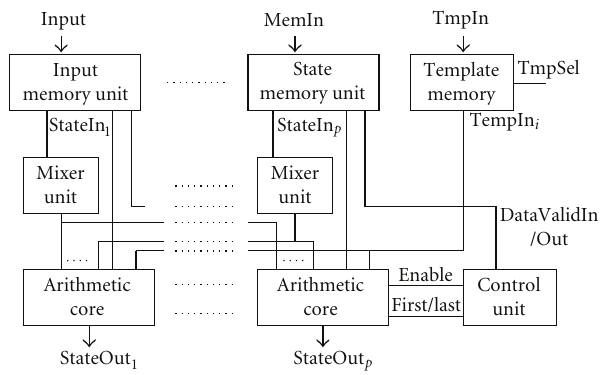
Figure 4: Structure of the optimized arithmetic unit to compute the di ff usion-type template (pipeline registers are not shown for